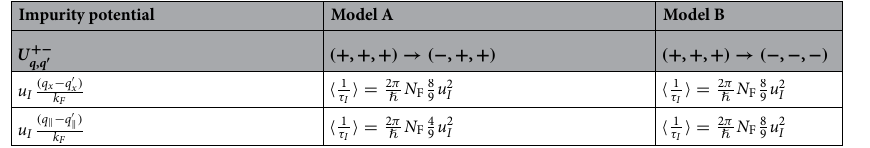
1 Table 1. Average inter-valley scattering rates τ I (cid:30) for anisotropic impurities potentials. Here p -wave ( (cid:31) and p z ) impurities potentials are considered. The p x -impurity potential (second row) does not differentiate the p p y or p z can tell the difference (last row). N F is the density of states at the two models, but the form of ∼ � = Fermi energy and u I characterizes the strength of the impurity potential.